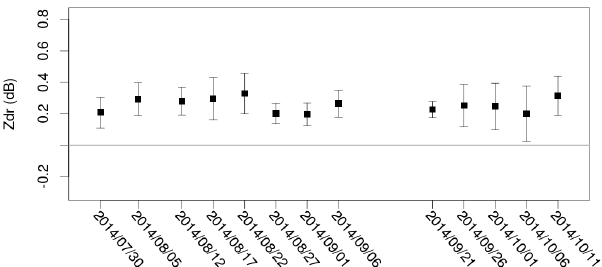
Figure 17. Daily analysis of the differential reflectivity of the solar interferences detected by the Monte Settepani radar during July– October 2014. The error bars represent the standard deviation of the daily Z dr